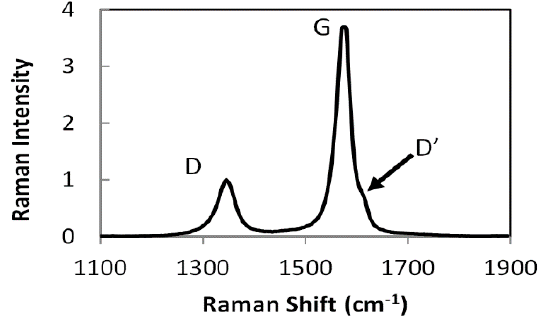
Figure 3. Raman spectrum of CNT sheet with G, D and D’ peaks.